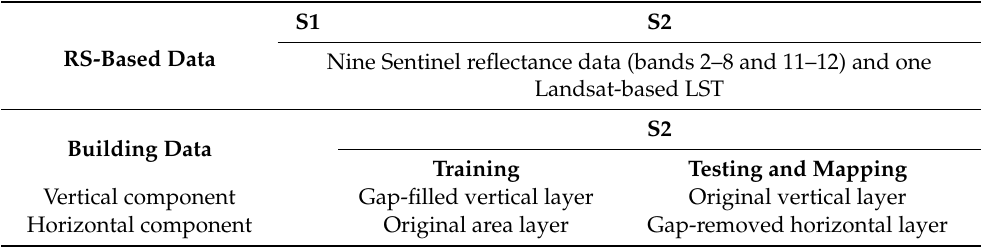
Table 3. The input variables for S1 and